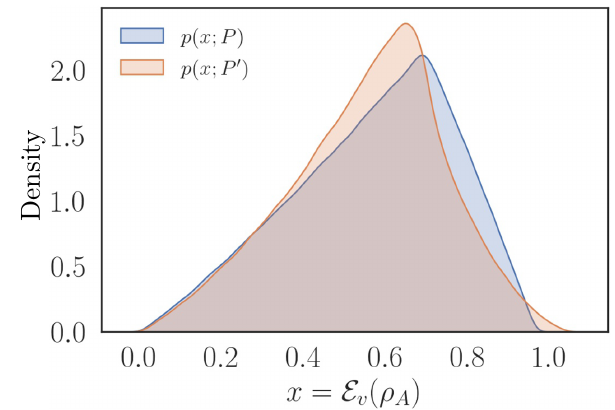
FIG. 10. The two-qutrit case d 2 = 9. The entangling power versus the gate typicality of all 9! permutations P ( 9 ) , treated as two-qutrit gates. The number of entangling classes corresponding to dual (and, equivalently, T dual) permutation matrices is 10.